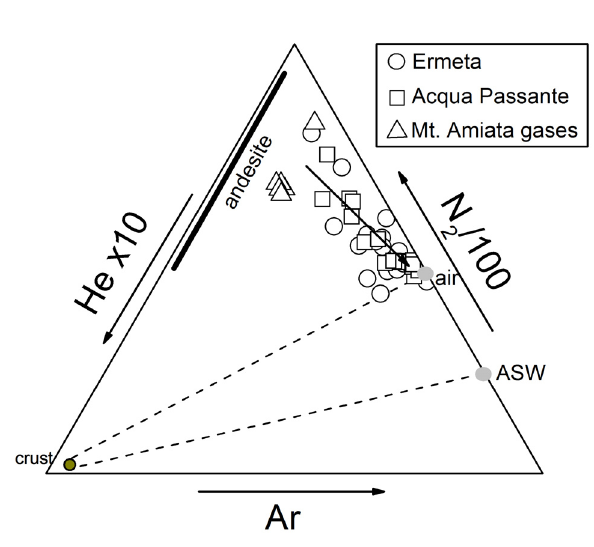
–He–Ar ternary diagram for the Ermeta and Acqua Figure 5. N 2 Passante gases and the Mt. Amiata gas discharges (by Tassi et. al. [2009]). ASW: air-saturated-water